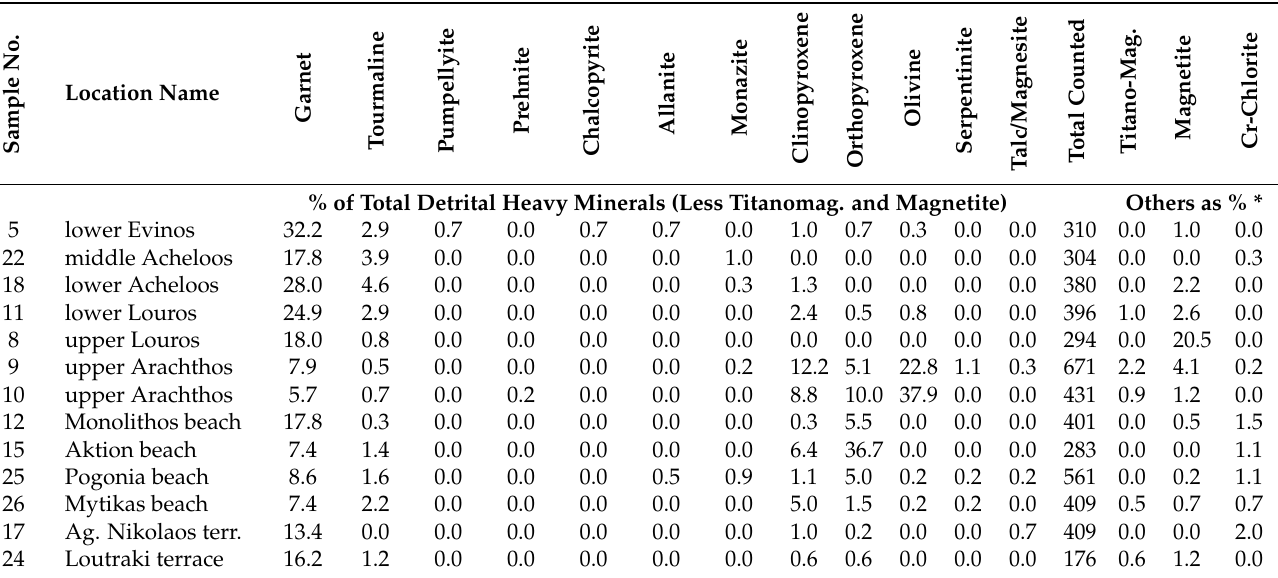
Table 3. Modal abundance of heavy mineral grains